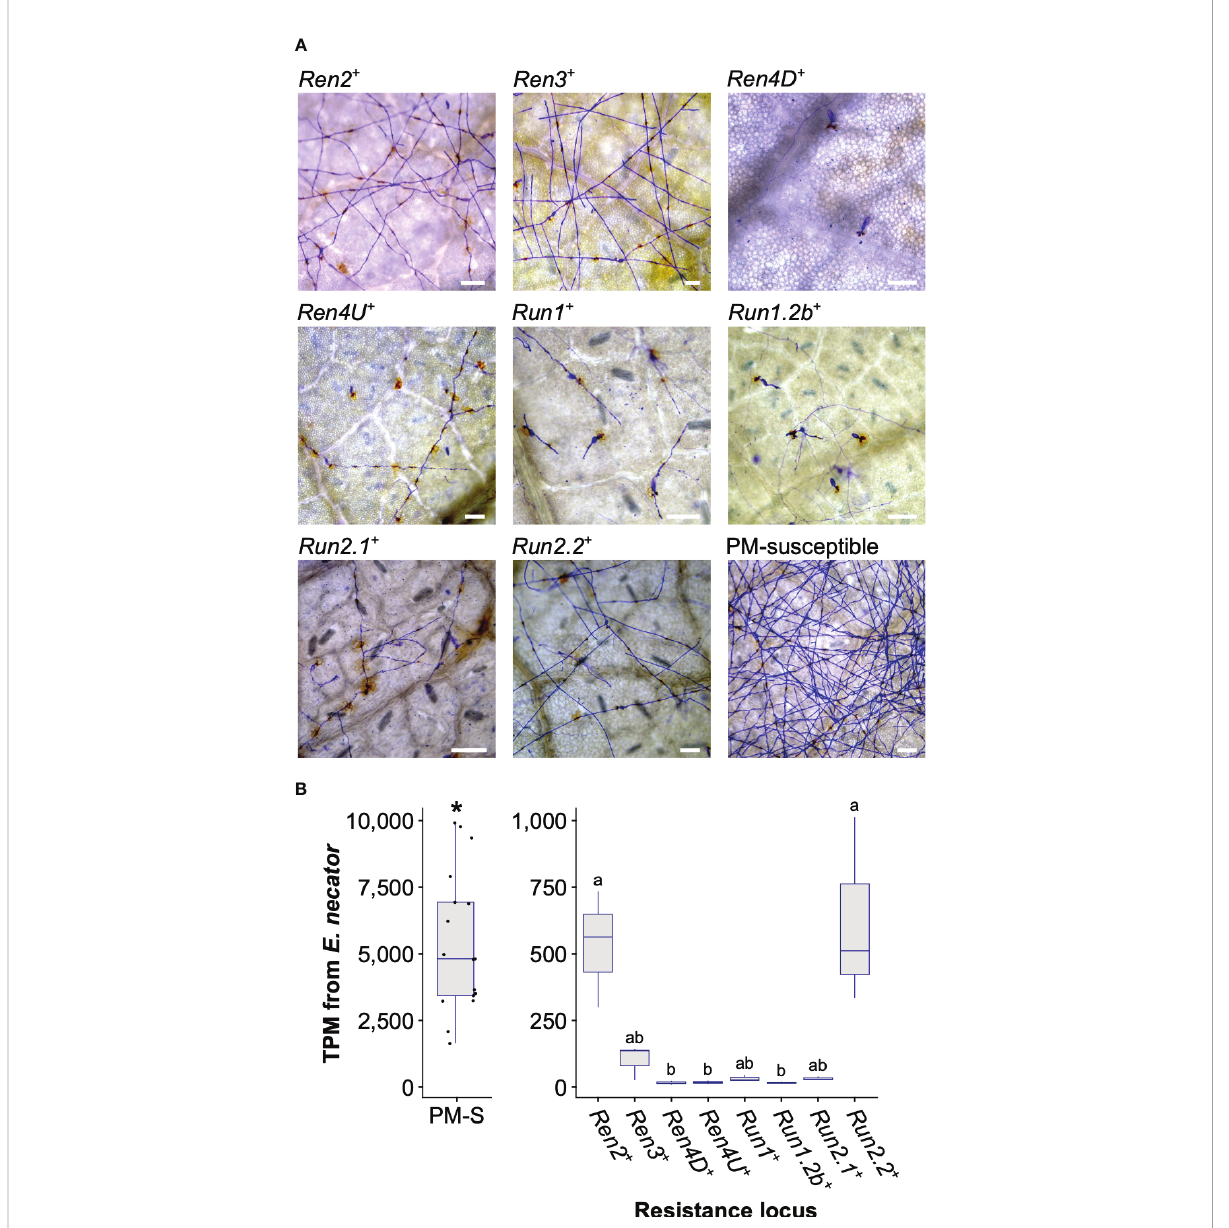
FIGURE 1 Powdery mildew disease development at 5 days post-inoculation. (A) Micrographs of detached leaves inoculated with E. necator . Scale = 100 m m. (B) Total Transcripts per Million (TPM) derived from E. necator transcriptome in PM-susceptible (PM-S) and PM-resistant accessions. Signi fi cant difference between grape accessions with and without a PM resistance locus is indicated by an asterisk (Kruskal-Wallis test, P = 4.0 x 10 -8 ). Signi fi cant differences between PM resistance loci are indicated by different letters (Kruskal-Wallis test followed by post hoc Dunn ’ s test; P ≤